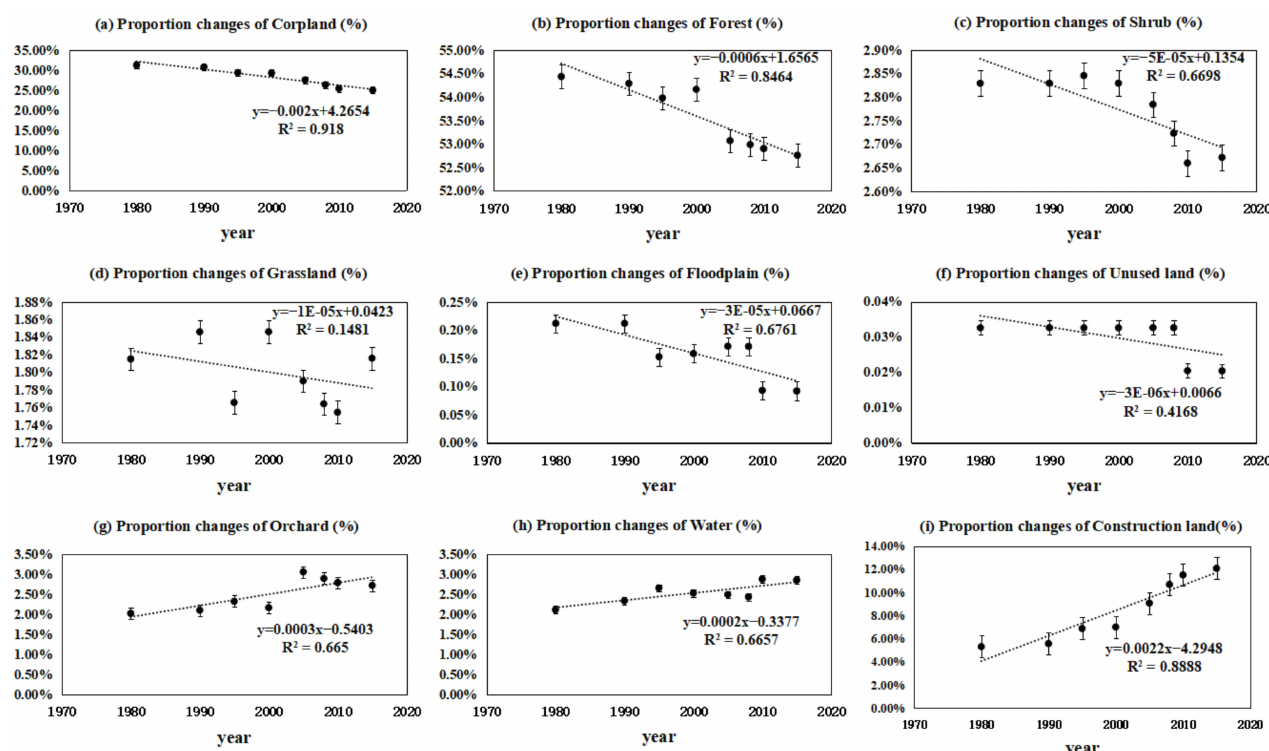
Figure 8. Temporal trends of each land use type ( a ) Proportion changes of Cropland, ( b ) Proportion changes of Forest, ( c ) Proportion changes of Shrub, ( d ) Proportion changes of Grassland, ( e ) Proportion changes of Floodplain, ( f ) Proportion changes of Unused land, ( g ) Proportion changes of Orchard, ( h ) Proportion changes of Water and ( i ) Proportion changes of Construction land during 1980 to